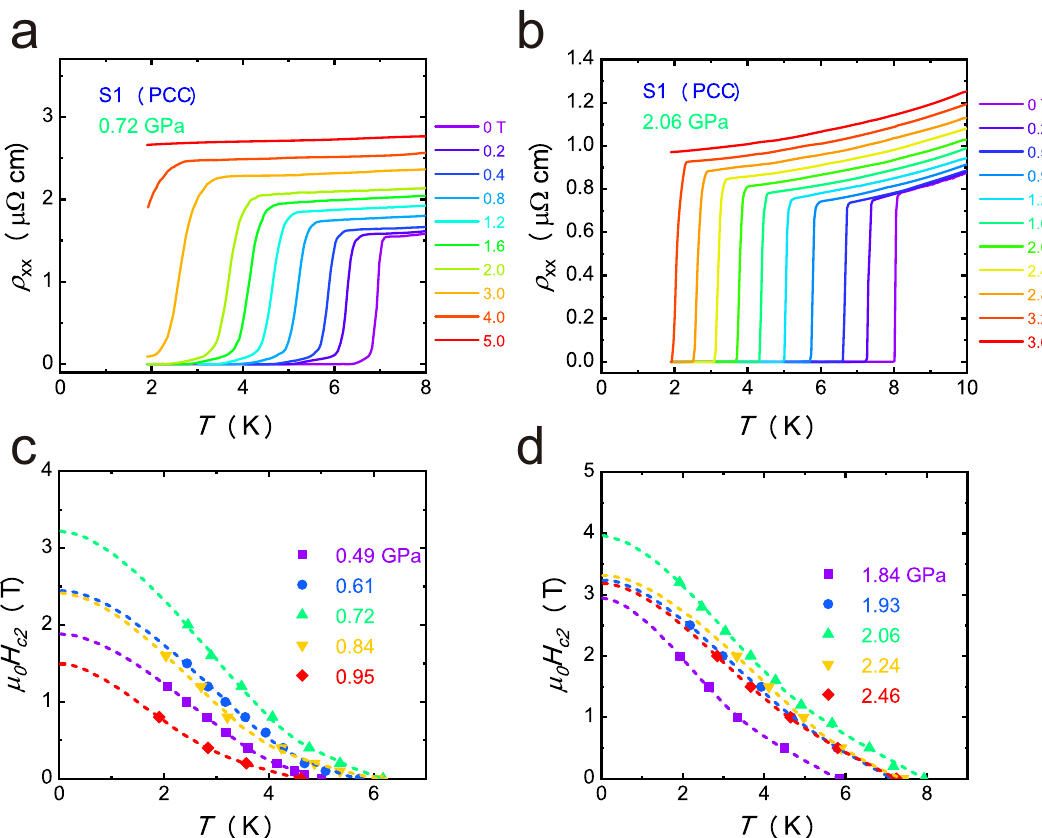
Fig. 2 Upper critical fi eld for CsV 3 Sb 5 single crystal under various pressures. Upper critical fi eld ( H c2 ) measurements for sample1 around P1 ( a ) and P2 ( b ) with magnetic fi eld applied along c axis. c , d The upper critical fi eld μ 0 H c2 vs. T under various pressures. The dashed lines are the fi tting curves by using the two-band